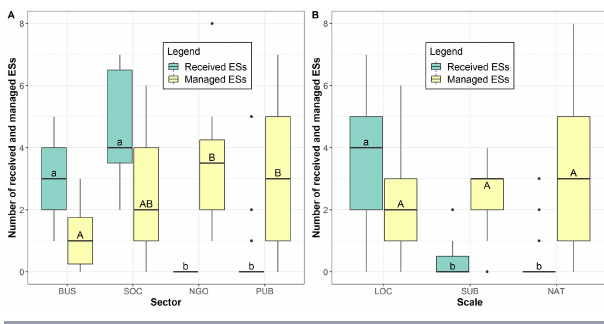
Fig. 4 . Number of received and managed ecosystem services (ESs) according to sector (A) and scale (B). BUS, business; LOC, local; NAT, national and international; NGO, nongovernmental organizations; PUB, public sector; SOC, civil society; SUB, subnational. Lowercase and uppercase letters indicate significant differences in the number of received ESs and managed ESs, respectively (pairwise permutation tests, with alpha = 0.05).